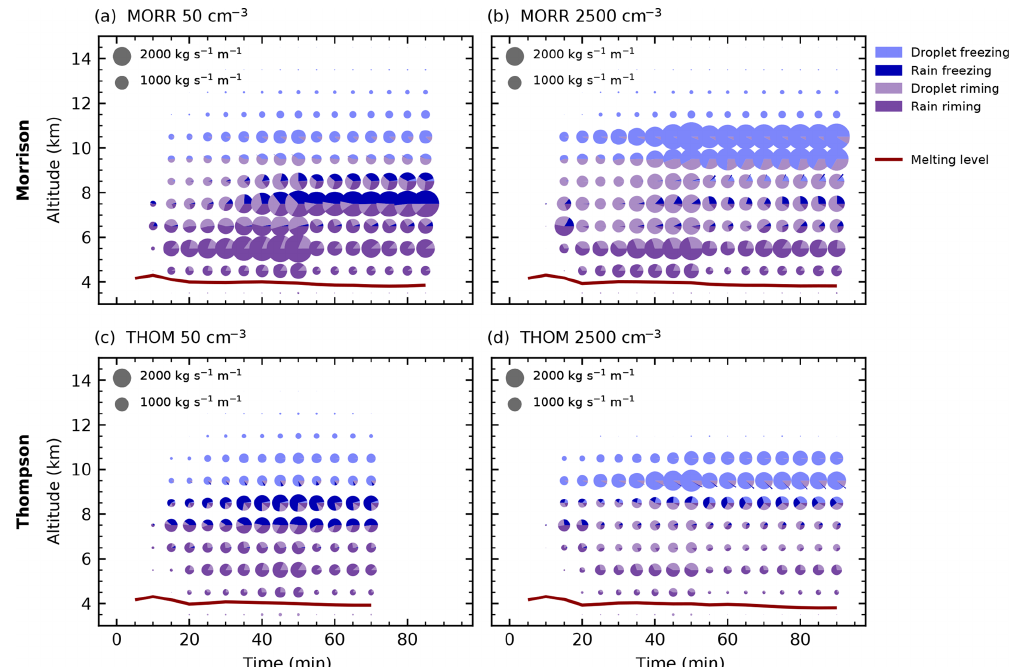
Figure 8. Time evolution of the microphysical process rates of freezing and riming processes as in Fig.